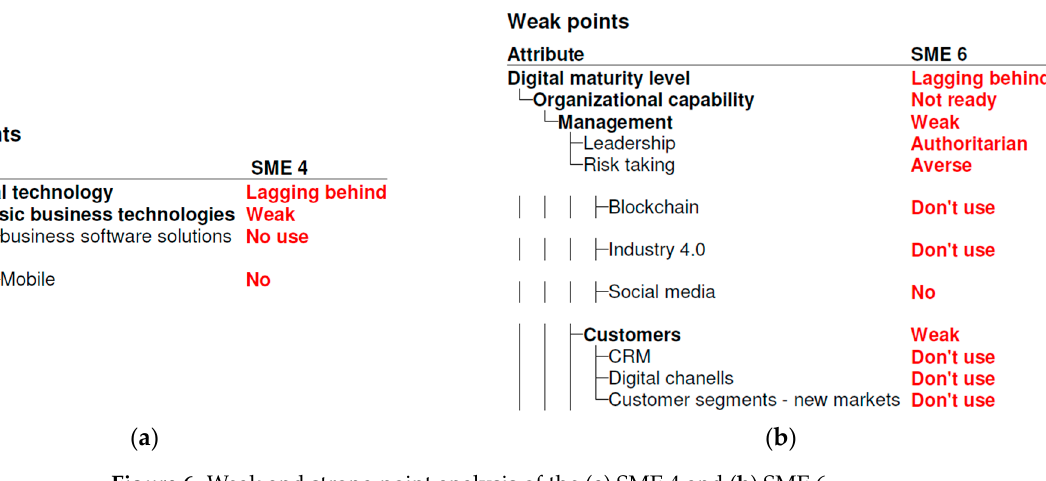
Figure 6. Weak and strong point analysis of the ( a ) SME 4 and ( b ) SME 6.